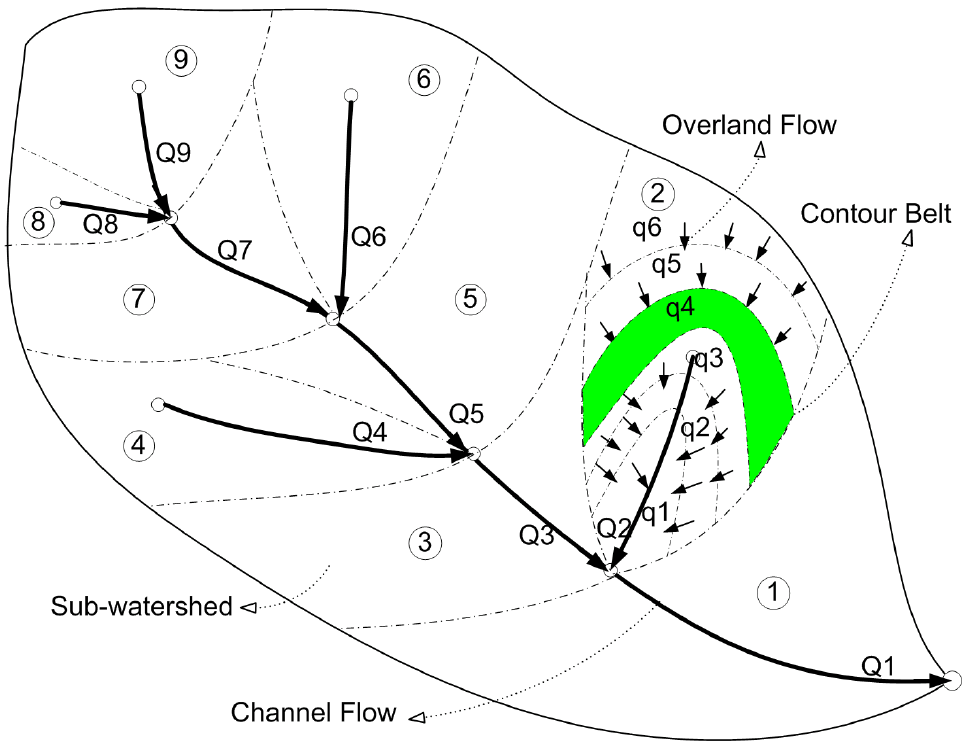
Figure 5. Horizontal structure of the WEP-L